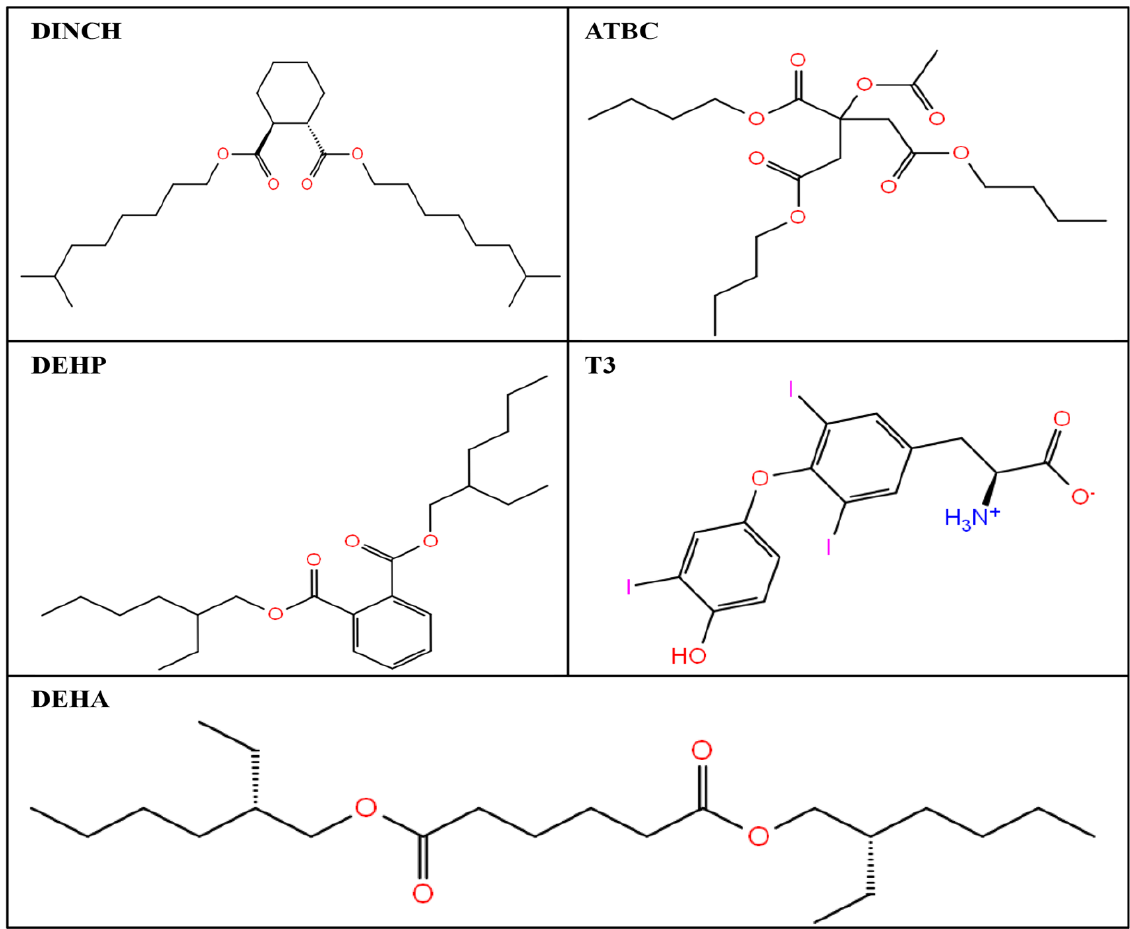
Figure 1. Two-dimensional structures of diisononyl hexahydrophthalate (DINCH), acetyl tributyl citrate (ATBC), di(2-ethylhexyl) phthalate (DEHP), thyroid receptor (TR α ) native ligand, triiodothyronine (T3), and di-(2-ethylhexyl) adipate (DEHA).